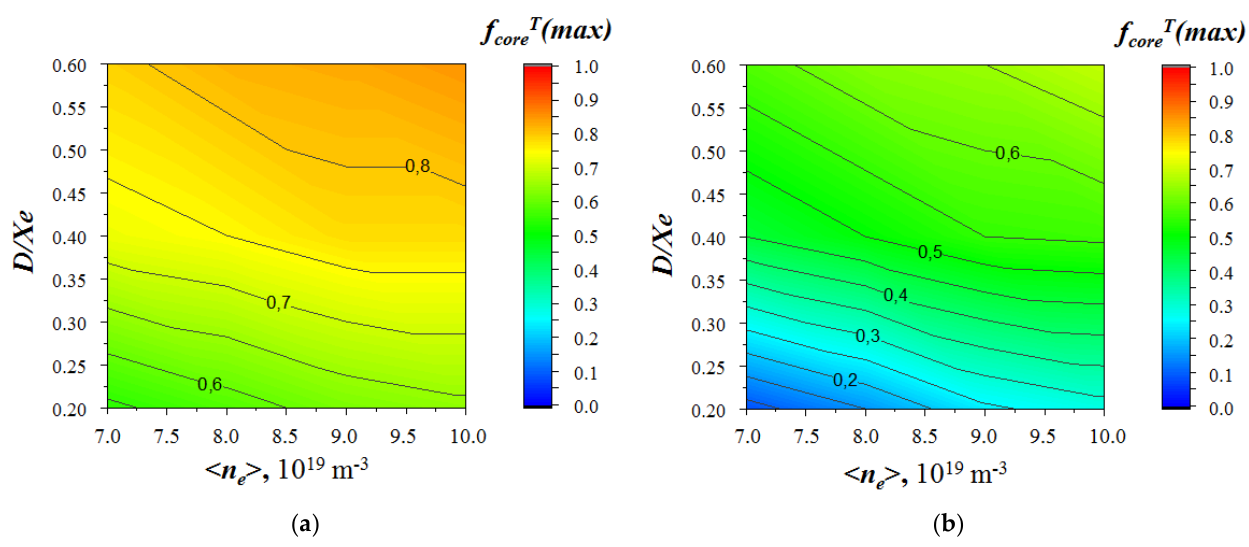
Figure 3. Maximum possible fraction of tritium f coreT (max) as a function of the n e and D/ χ e parameters for the ( a ) D + T and ( b ) D beams. The scale on the right shows the correspondence of the color and f core T (max) values.